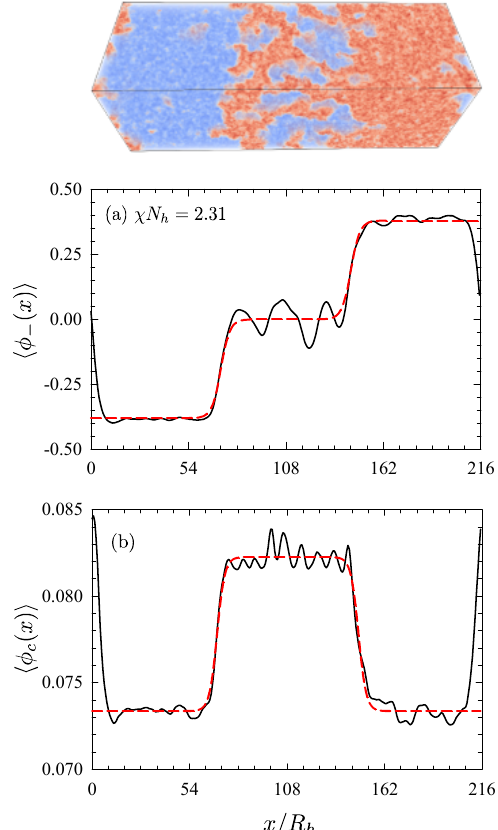
Figure 9. ( a ) Composition and ( b ) copolymer concentration profiles for three-phase coexistence at χ N h = 2.31. The dashed curves are fits to hyperbolic tangent profiles. Adapted from Ref.